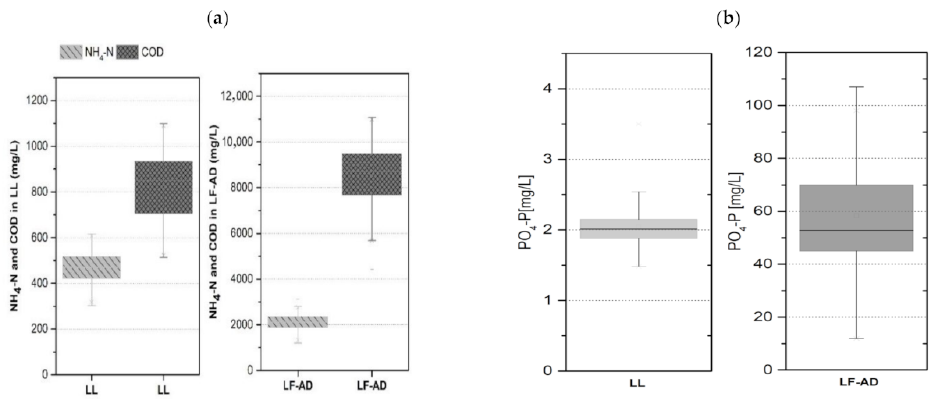
Figure 3. ( a ) Overview of NH 4 -N, COD, and ( b ) PO 4 -P concentrations in the LL and LF-AD over the course of the entire